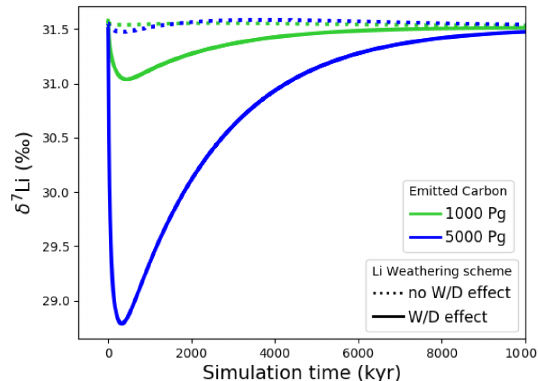
Figure A4. Time series of marine 187 Os / 188 Os changes in re- sponse to an immediate release of two different masses of C into the atmosphere–ocean system with and without Os scavenging from the water column